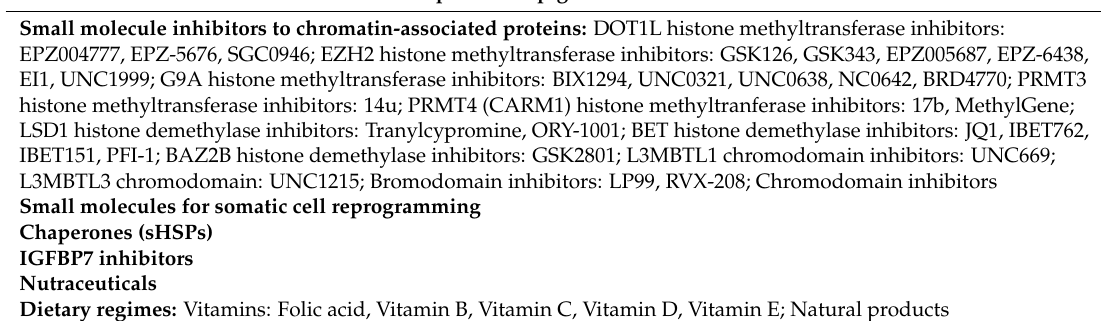
Other potential epigenetic